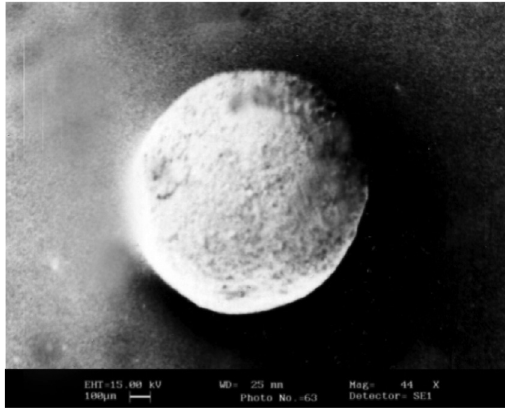
FIGURE 5 - Scanning electron micrograph of palmitic acid coated pellets TABLE II - Evaluation of uncoated and hot-melt enteric coated pellets Formulations % Friability